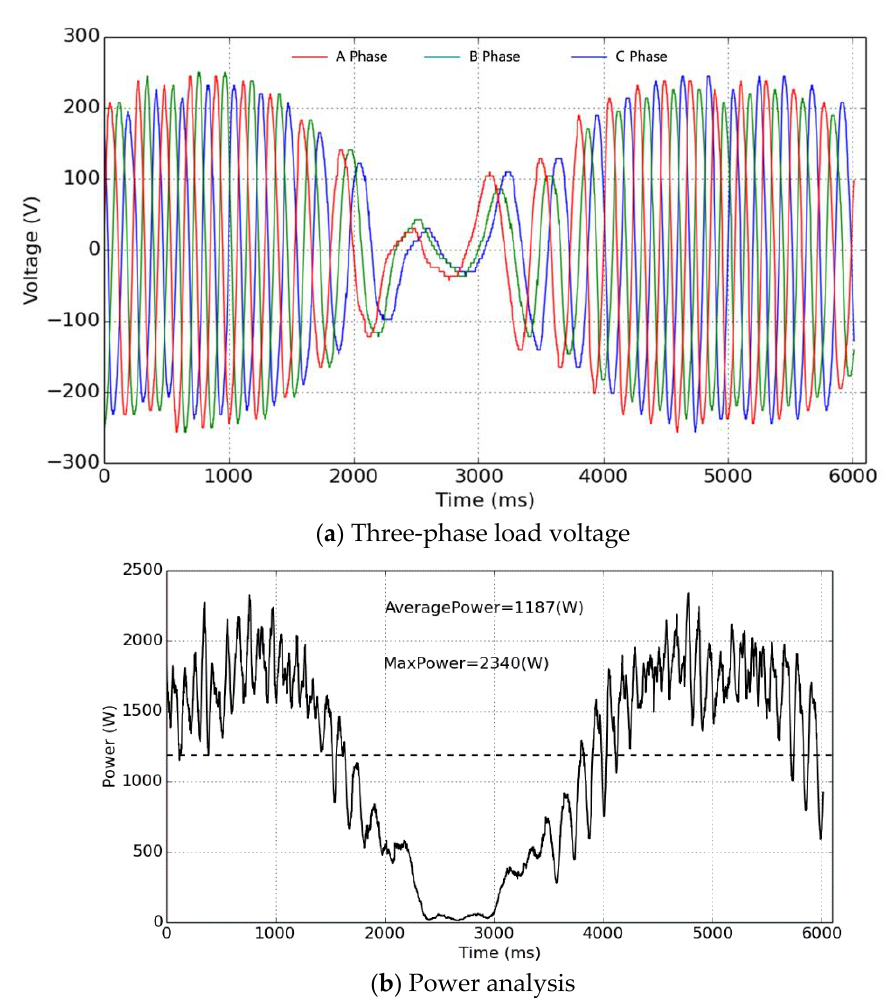
Figure 9. Output load voltages and power analysis (the ocean wave period is about 8.5 s). Table 4. The experiment conversion efficiency from ocean wave power into electric power. Power (kW) Wave Amplitude (m) Wave Period (s)